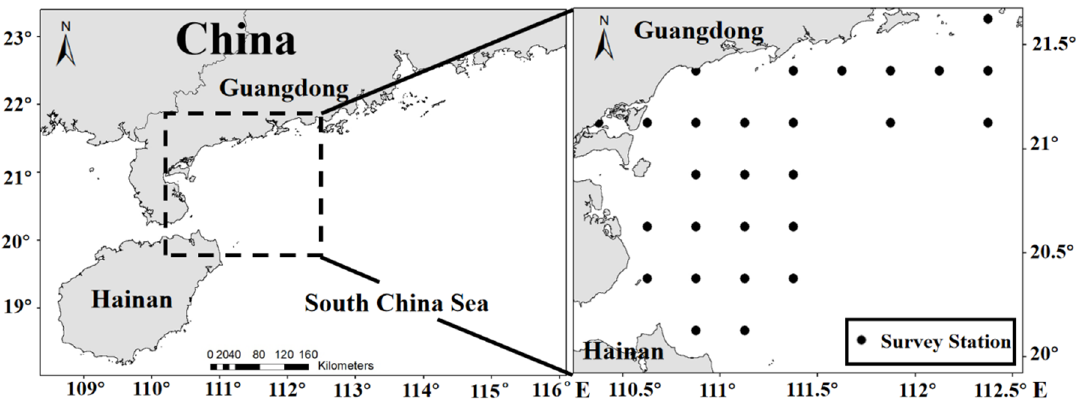
Figure 1. Research area and survey stations. Dotted box shows the extraction range of satellite data.